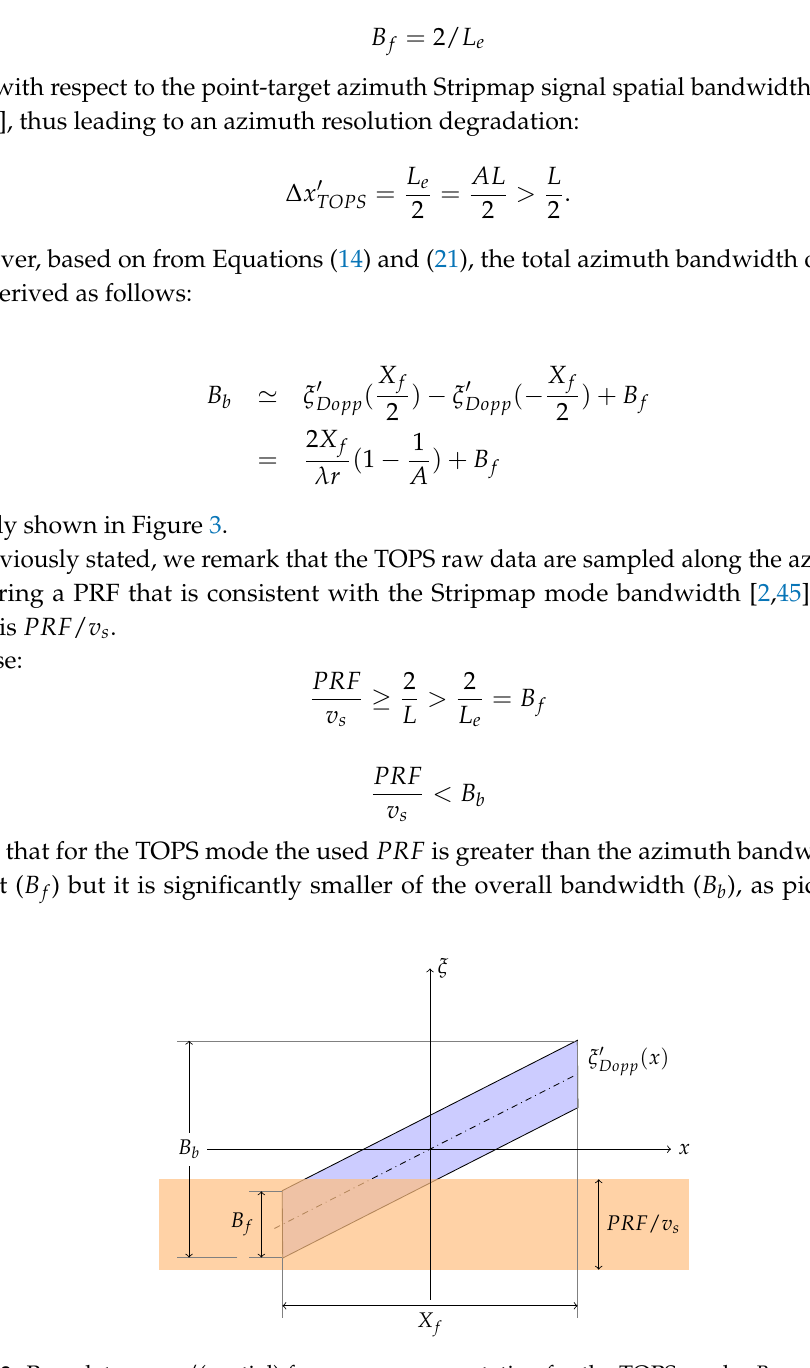
Figure 3. Raw data space/(spatial) frequency representation for the TOPS mode: B f represents the bandwidth for a single point target, B b is the overall bandwidth, PRF / v s is the spatial azimuth pulse ( x ) is the Doppler Centroid (spatial) frequency considered here as a function repetition frequency, ζ (cid:48) Dopp of the azimuth coordinate